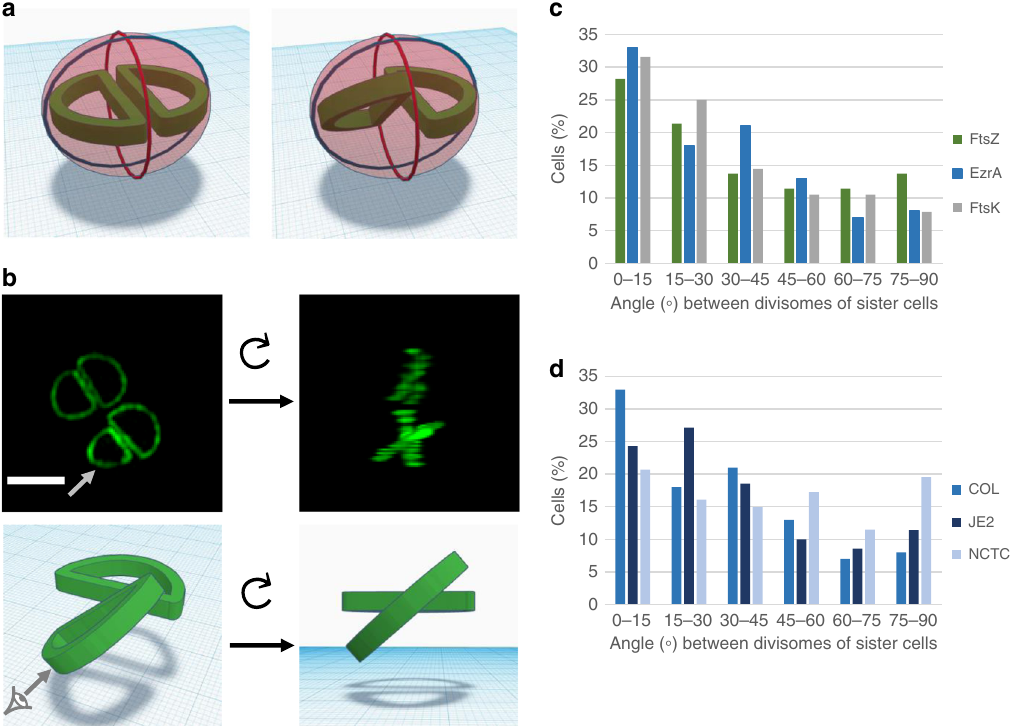
Fig. 2 Sister cells can divide in different planes. a Model of cells undergoing division showing the previous (blue line), current (red line) and next (green D shape) division planes. Left image: if cells divide in three consecutive orthogonal planes then sister cells will inevitably divide in the same plane, perpendicular to the previous and current division planes. Right image: if the future division plane is not the same in both sister cells, then the orthogonal geometry of division is not respected in at least one of the sister cells, as exempli fi ed by the left hemisphere where the next division will occur in a plane that is perpendicular to the current plane of division (in red) but not to the previous one (in blue). b Top panel: top view of 3D rendering of a Z-stack of images of COL EzrA-sGFP cells. Left panel shows the top view and right panel shows the view after rotating the 3D reconstruction to a perspective where division planes become perpendicular to the viewing plane, appearing as a cross. Scale bar, 1 µ m. Bottom panel: model of the divisome of two sister cells, illustrating their orientation before and after rotation. Grey arrow indicates point of view after rotation. A full fi eld of view can be accessed in https:// fi gshare.com/s/907e54dd2d24e7c5dd05. c , d Histograms of angles formed by divisomes of sister cells showing that two sister cells very often select different planes of division. Measurements were performed using Z-stacks of images obtained from c COL strains expressing FtsZ 55-56 GFP ( n = 131), EzrA- GFP ( n = 100) or GFP-FtsK ( n = 76) and d COL ( n = 100), JE2 ( n = 70) and NCTC ( n = 87) strains expressing EzrA-GFP and analysed using automated software (see Methods). Two to four biological replicates were imaged for each strain. Quanti fi cations were done from a single experiment for each strain. Source data are provided as a Source data fi